Question: What visual encoding does this figure use to show its data?
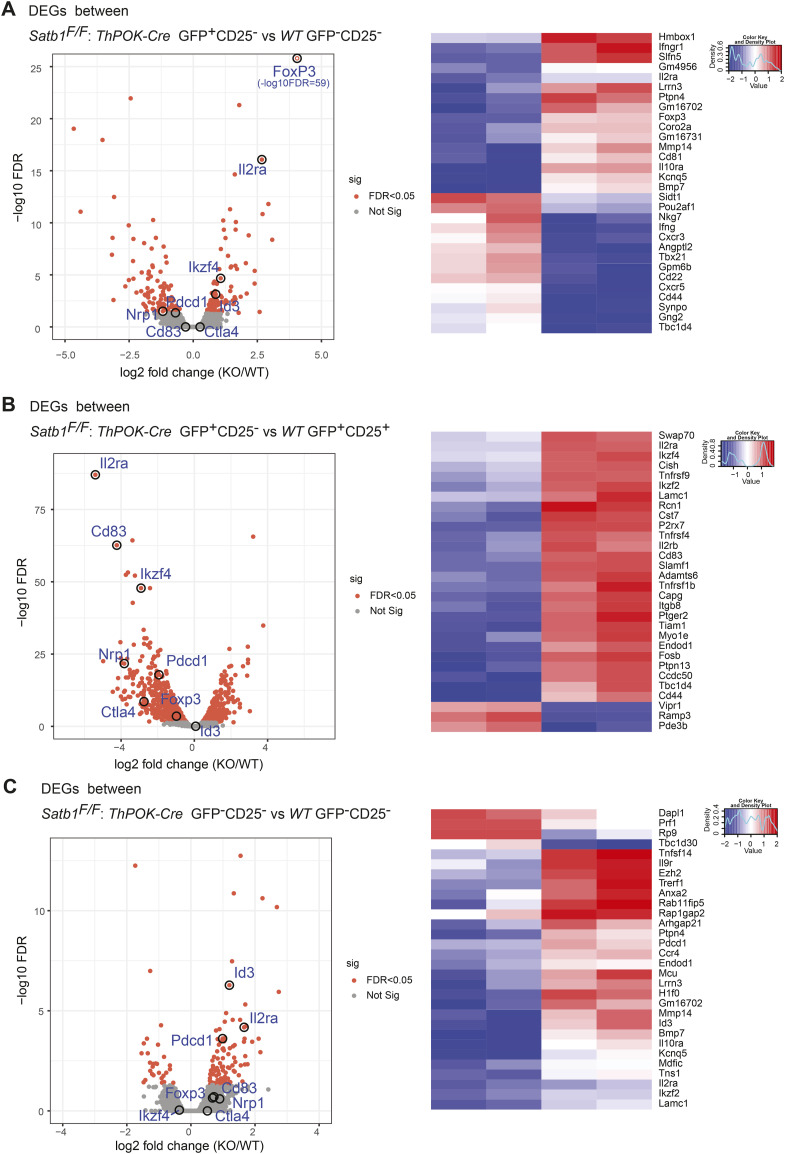
Answer: heatmap